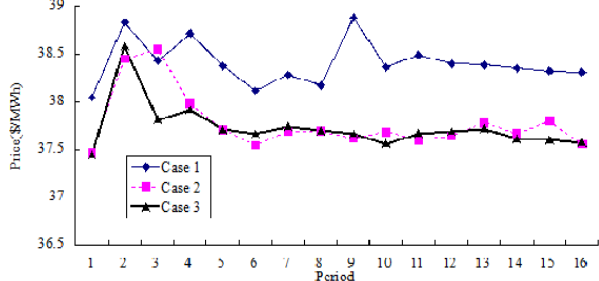
Figure 7. Comparative results of average price variation for 3 Cases (for 16 periods).